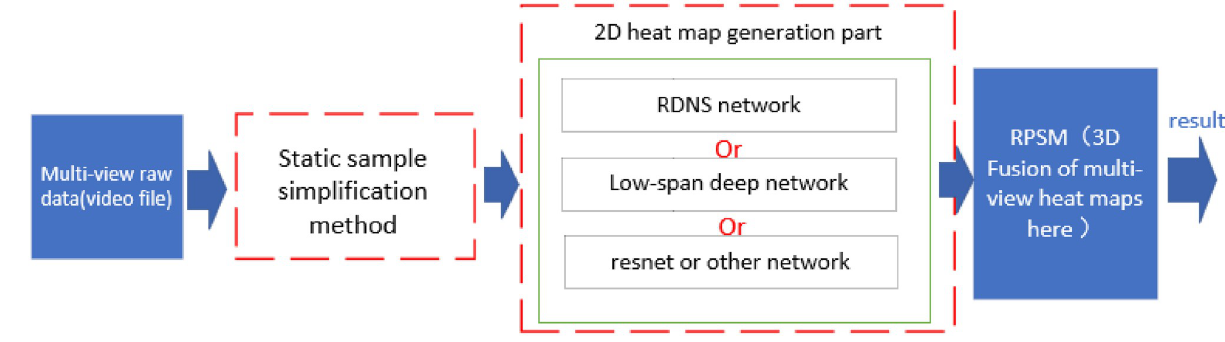
Fig 2. The realization and structure of our work, and its operation